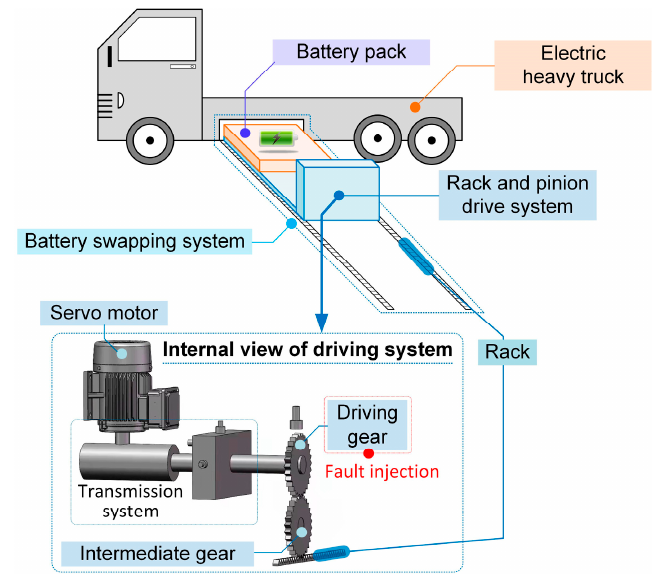
Figure 18. Structure of battery swapping system.